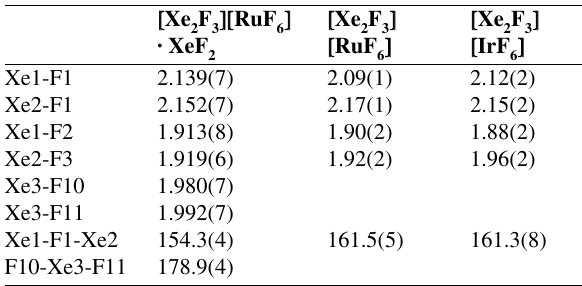
Table 2 . Selected distances (Å) and angles (°) in [ Xe XeF